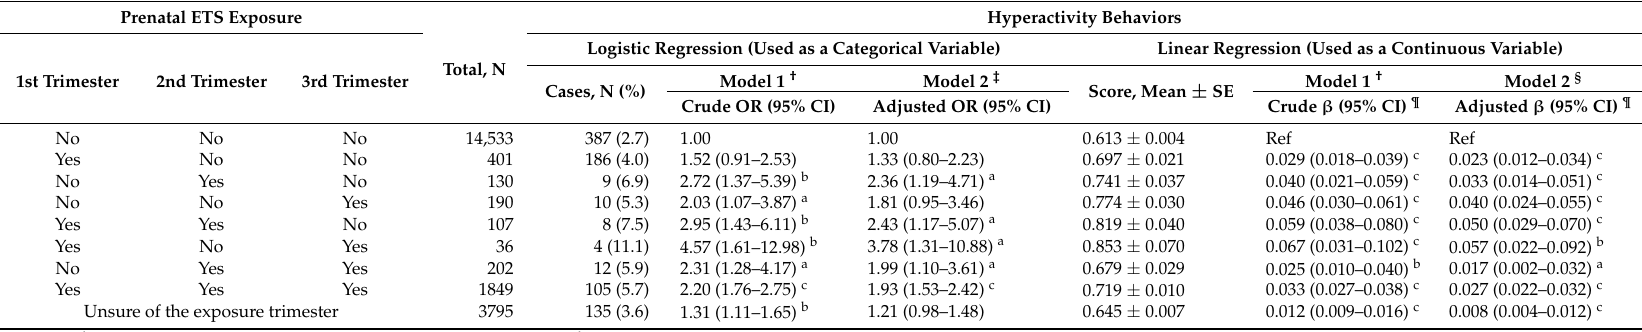
Table 3. Results from logistic and linear regression models on the association between hyperactivity behaviors of young children and combinations of prenatal environmental tobacco smoke (ETS) exposure in different trimesters of